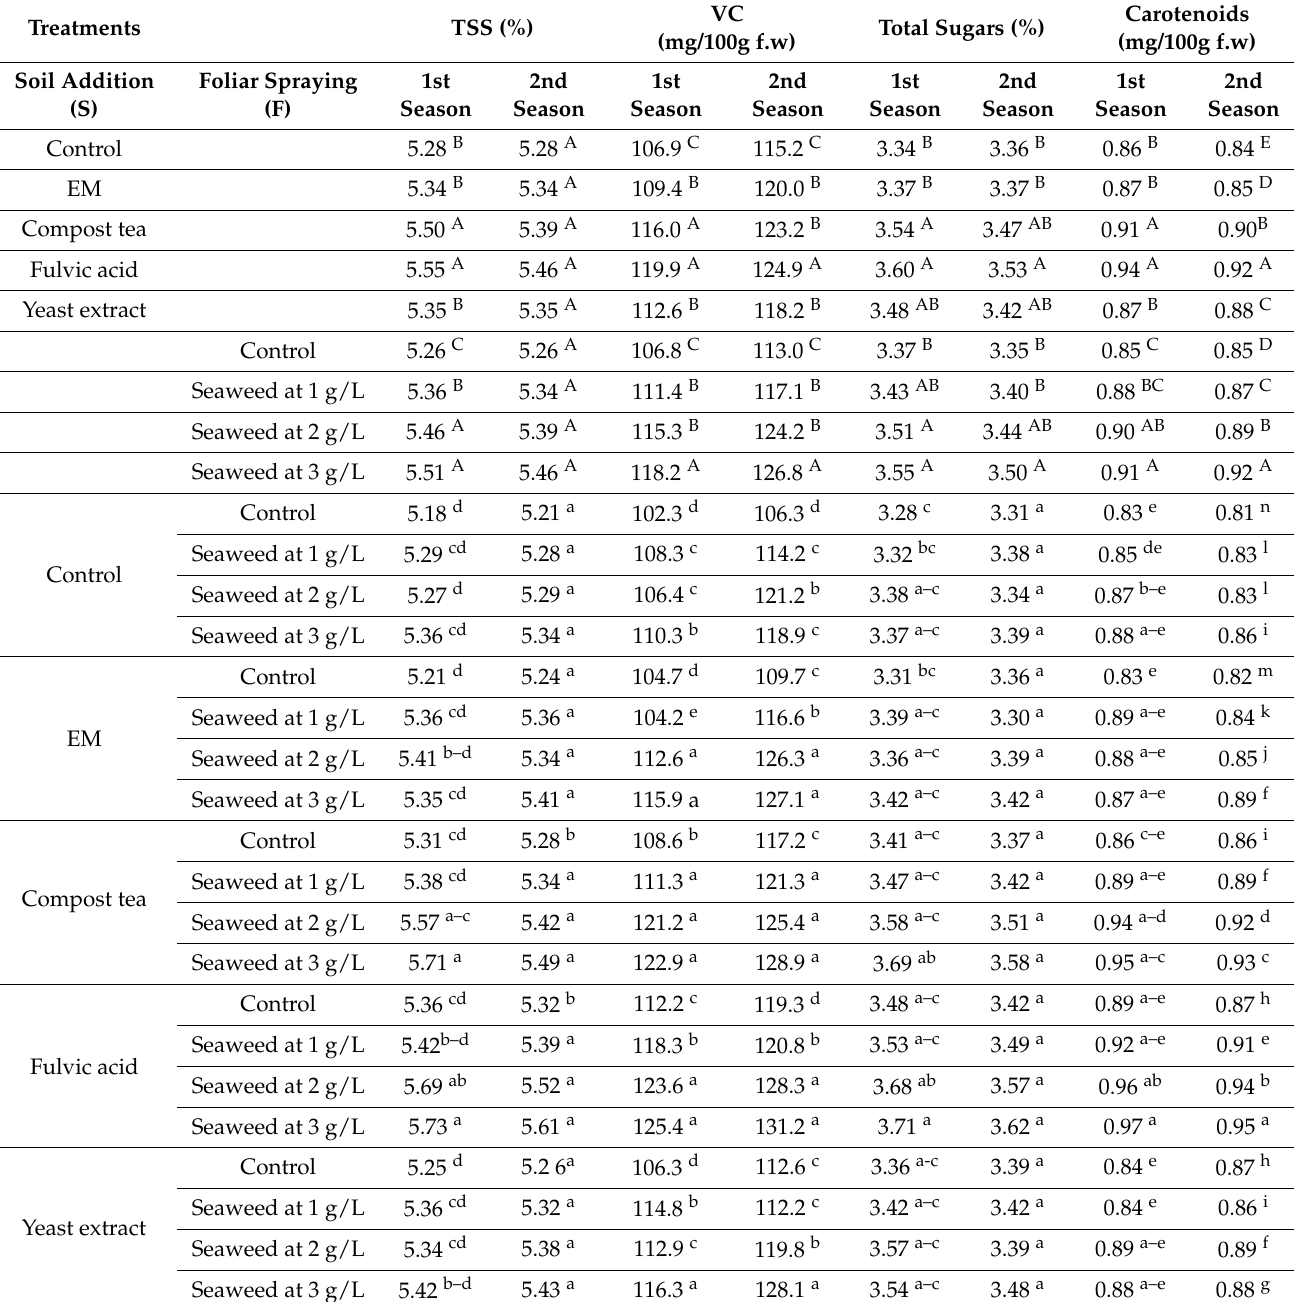
Table 6. Effects of soil addition of EM, compost tea, fulvic acid, yeast extract, and foliar spray with seaweed extract and their combination on the chemical quality of the fruit of sweet pepper plants during the 2019/2020 and 2020/2021